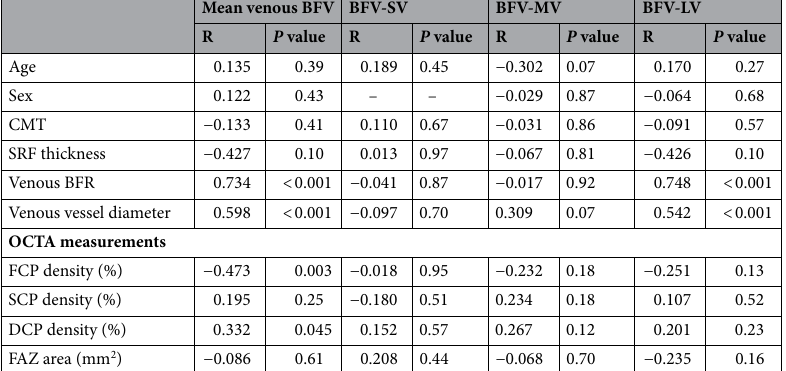
Table 3. Venous blood flow velocity and its associated factors. All P values were calculated using Pearson’s correlation test. BFR blood flow rate, BFV blood flow velocity, BFV-SV small venule blood flow velocity (diameter smaller than 40 μm), BFV-MV middle venule blood flow velocity (diameter between 40 and 80 μm), BFV-LV large venule blood flow velocity (diameter greater than 80 μm), CMT central macular thickness, CSC central serous chorioretinopathy, DCP deep capillary plexus, FAZ foveal avascular zone, FCP full capillary plexus, OCTA optical coherence tomography angiography, SCP superficial capillary flexus, SRF subretinal